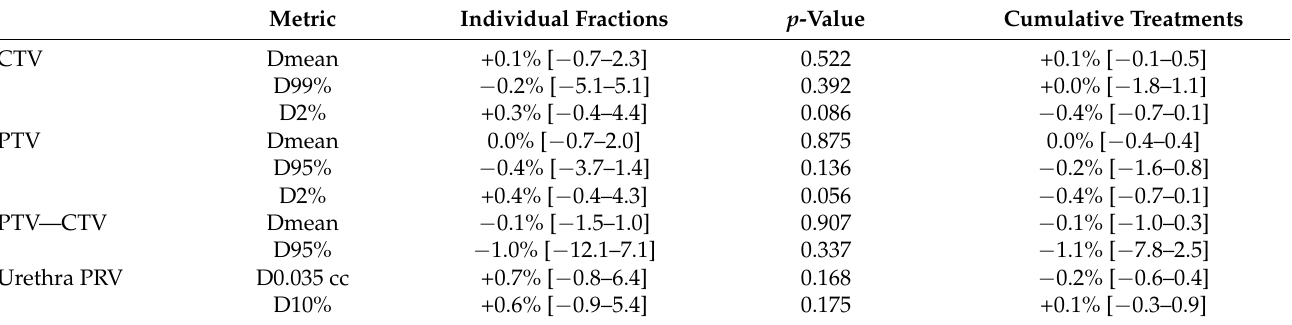
Table A1. Mean and range (over all fractions and patients) of the percentage differences in target and OARs dosimetric parameters between intrafraction motion-inclusive recalculations considering the observed case A prostate motion data and the planned dose distributions. p -values ( p < 0.05) for the individual fractions’ dose parameters are also